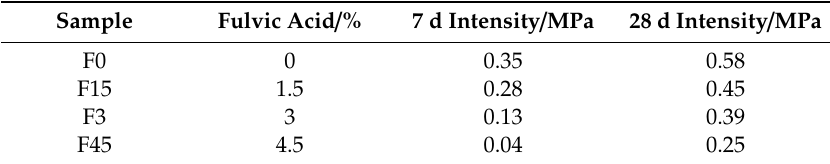
Table 3. Strength of sludge solidified sediment with di ff erent organics content.